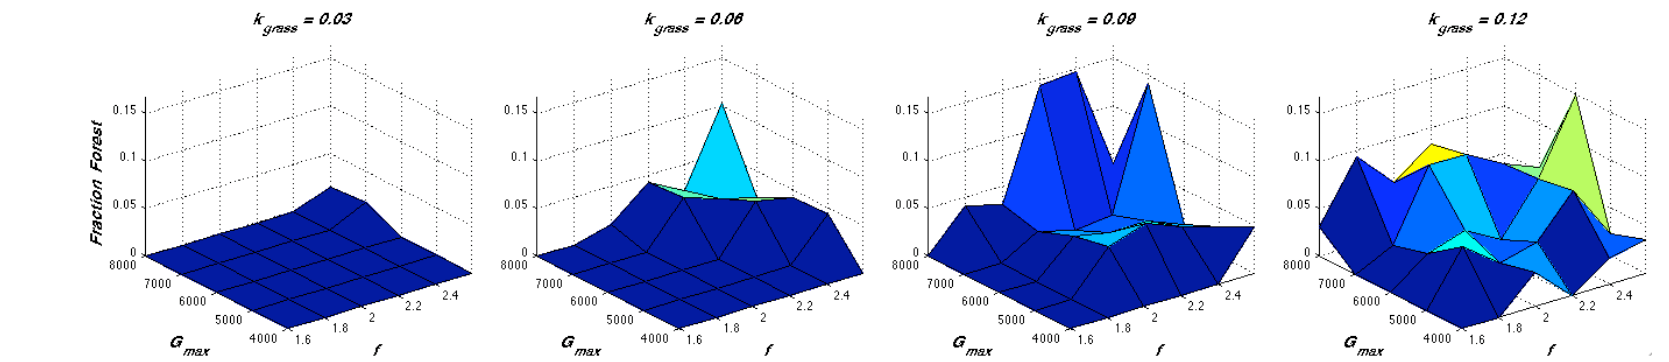
Figure A2.7: Fraction of property in forest across dimensions of grass capacity G growth rate k (/t). Individual surfaces show forest fraction as a function of grass capacity and stocking factor f at a constant intrinsic grass growth grass